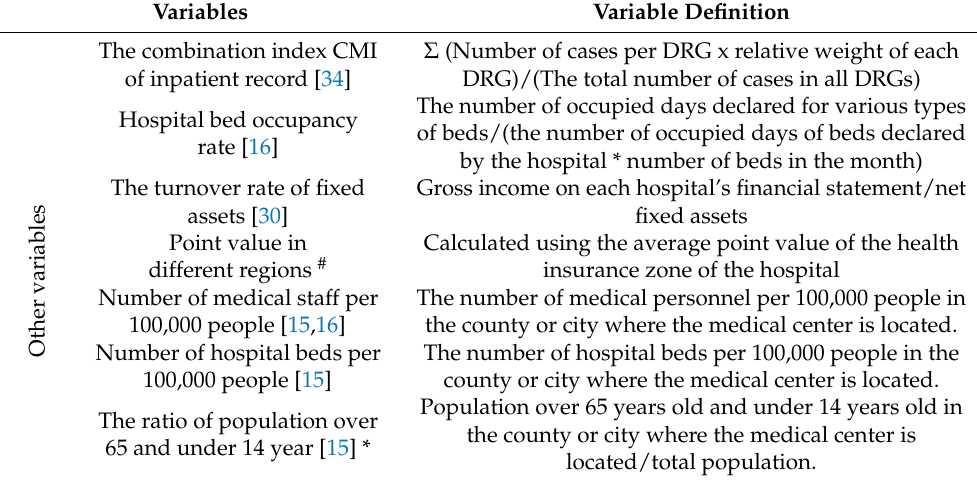
Table 2. A list of studies of other TOBIT regression